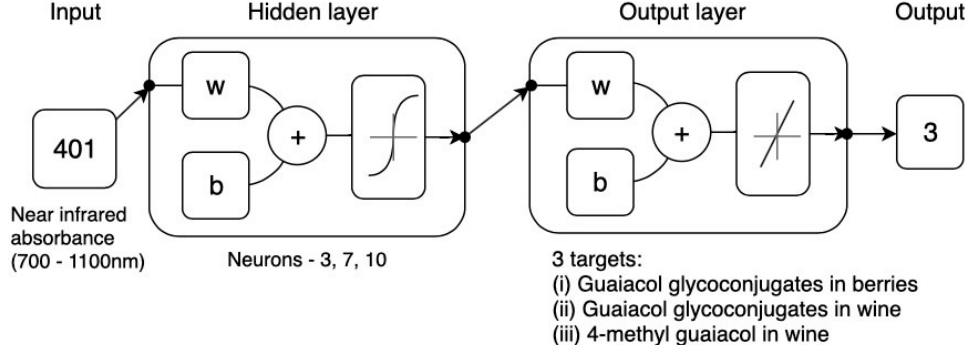
Figure 4. Diagram of the two-layer feedforward network with a tan-sigmoid function in the hidden layer and a linear transfer function in the output layer. For hidden and output layers, w = weights and b = biases. Neuron trimming exercise is included in the diagram.